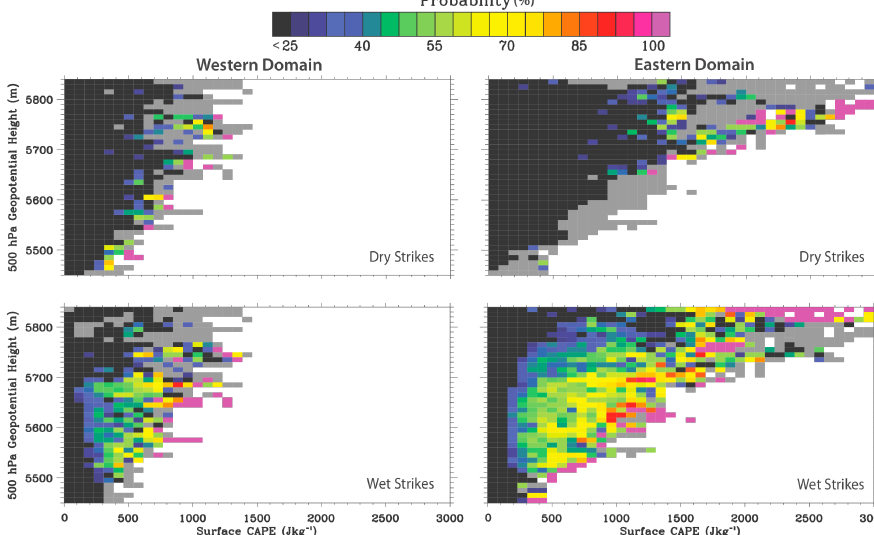
Figure 8 Fig. 8. Averaged probability of lightning activity (dry or wet) occurring within a grid box as a function of CAPE and 500hPa geopotential heights for the western domain (left) and the eastern domain (right). The observed CAPE and height values for 2000-2006 with a probability of dry lightning occurrence ≥ 25% are shaded in color, values with a probability of dry lightning occurrence between 0 and 25% are shaded in black, values without lightning occurrence are shaded in grey, and white areas do not contain observed